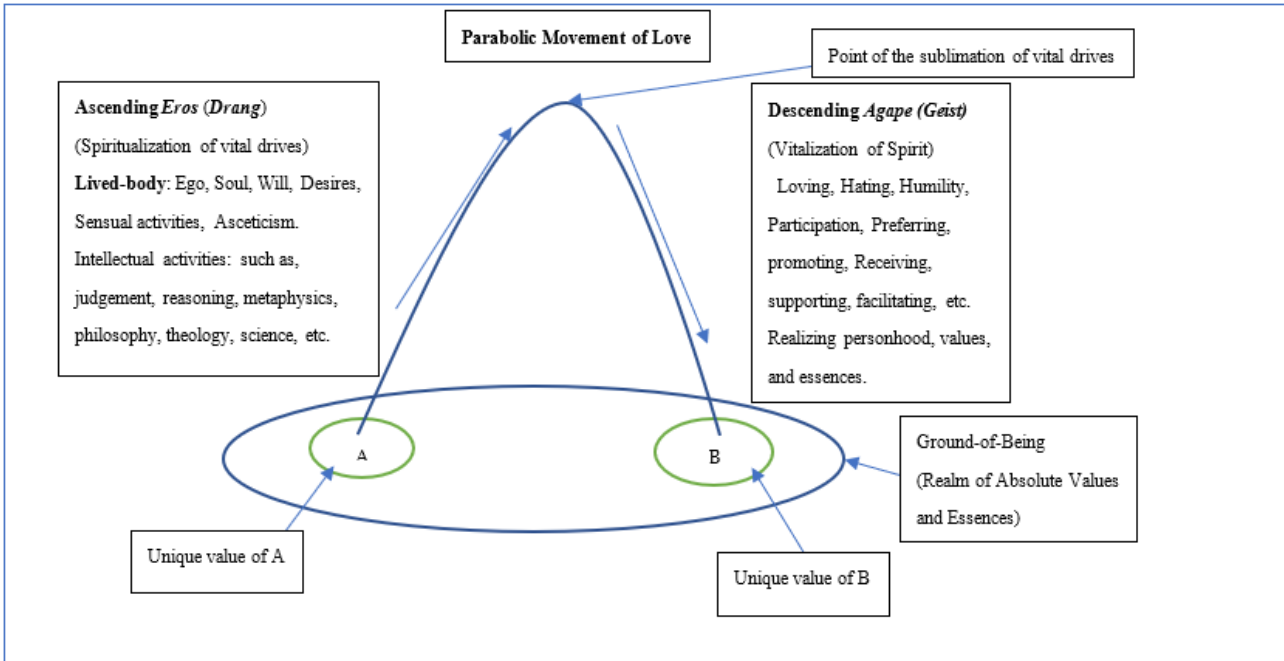
Figure 1. A visualization of the movement of love showing the directions of eros and agape, the point of sublimation of drives, and the World-Ground.